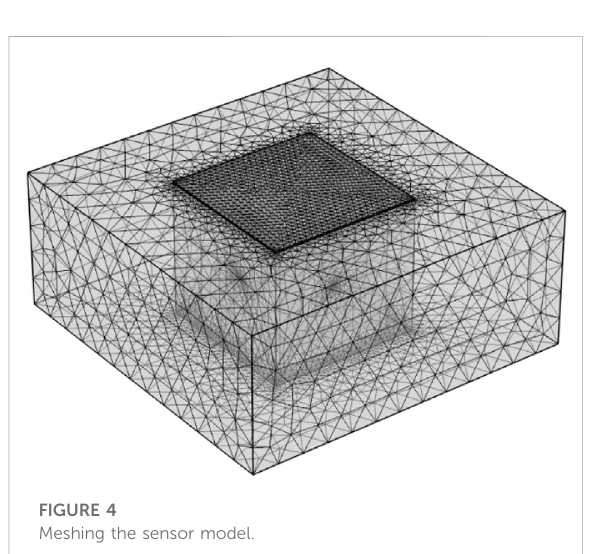
FIGURE 4 Meshing the sensor model.